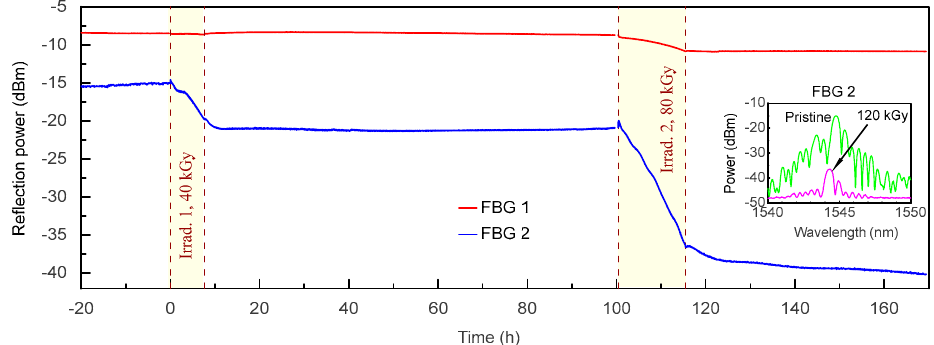
Figure 3. The Bragg wavelength reflection power evolution during the first (40 kGy) and the second (80 kGy) irradiation sessions. (80 kGy) irradiation